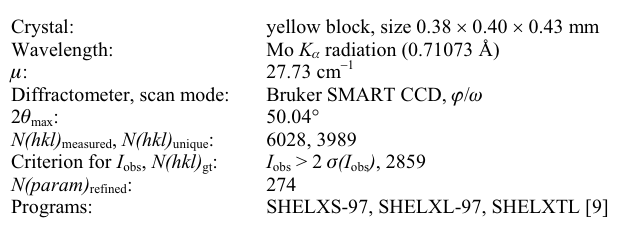
Table 1. Data collection and handling.